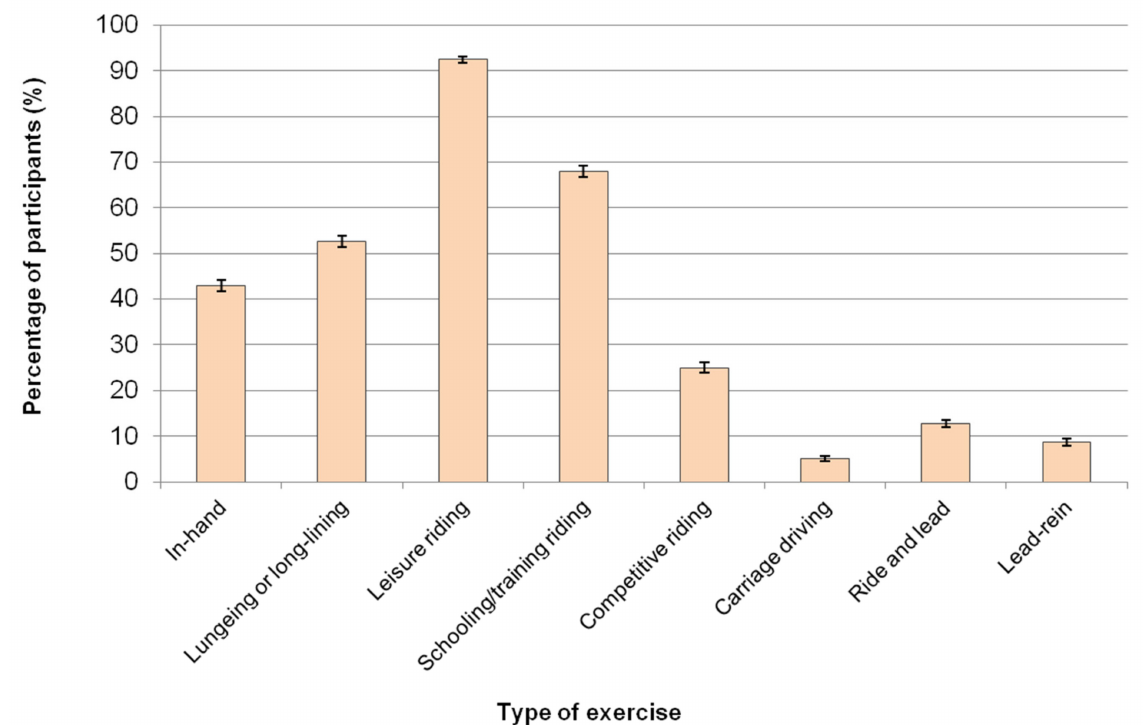
Figure 1. The types of exercise UK equestrians ( n = 5427) reported doing with their horses at least once a week. Equestrians could select multiple exercise options; therefore, the exercise categories are not mutually exclusive. Error bars represent 95% confidence intervals.